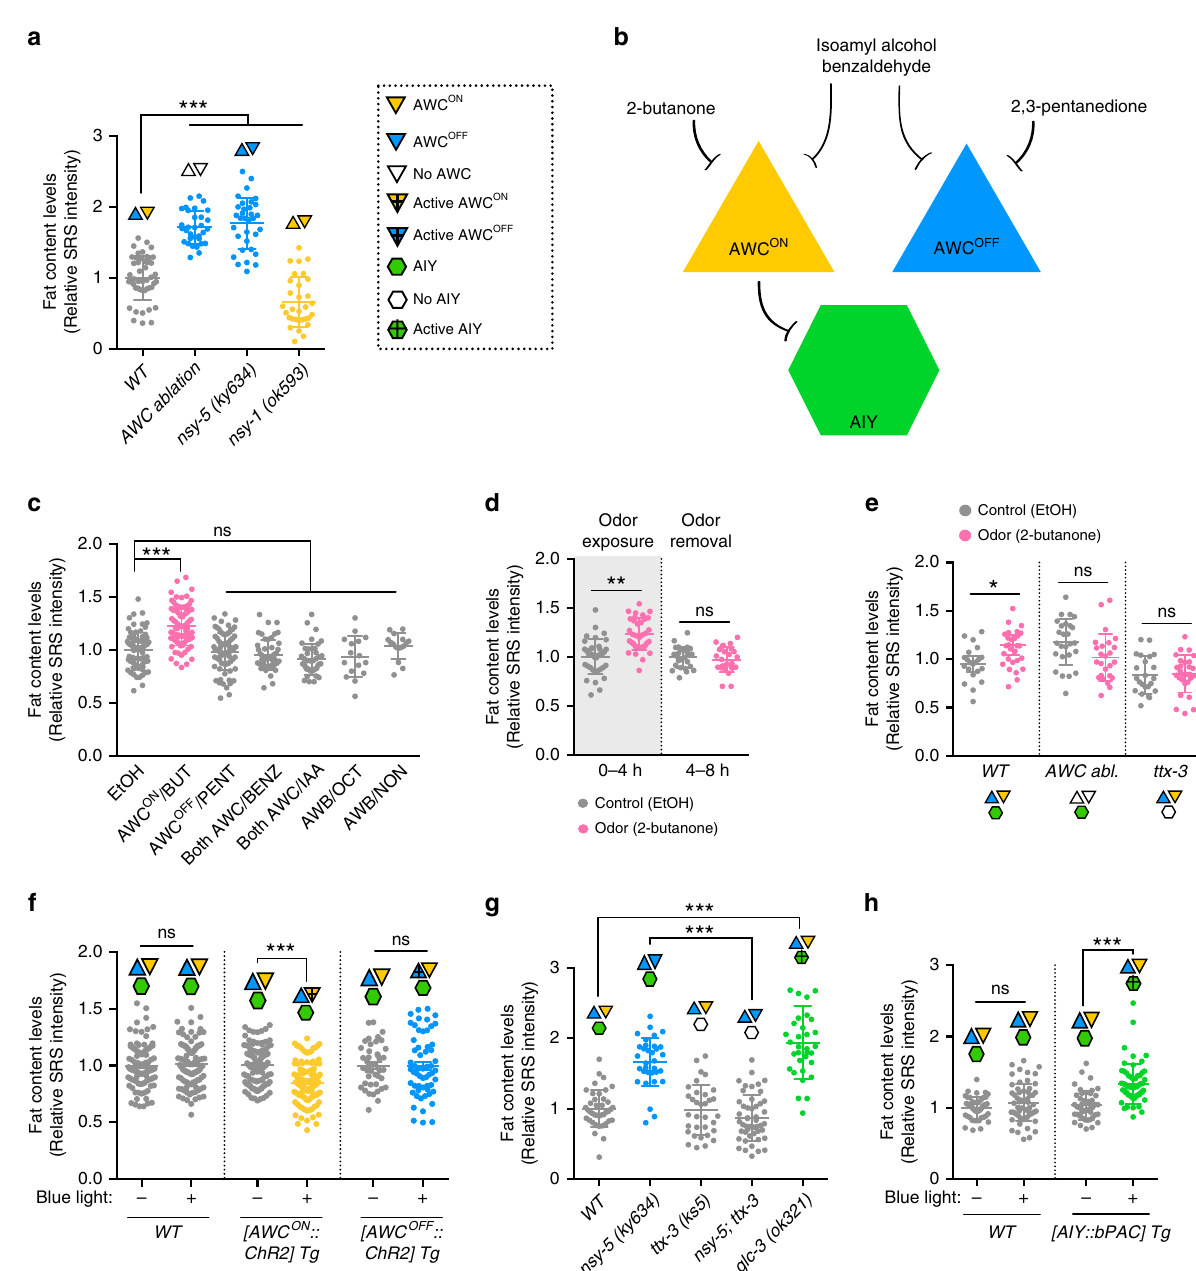
Fig. 3 Speci fi c odors and responding olfactory neural circuit regulate fat metabolism. a Genetic ablation of AWC neurons increases fat storage, while the loss of the asymmetric AWC OFF ( nsy-1 = AWC ON/ON ) or AWC ON ( nsy-5 = AWC OFF/OFF ) neuron leads to reciprocal changes, decreasing or increasing fat levels, respectively. Representative SRS images are in Supplementary Fig. 6c. b Scheme of the odorants and their responding neural circuit with asymmetric AWC olfactory neurons and AIY interneurons. c Exposing WT to 2-butanone that inhibits AWC ON neurons is suf fi cient to increase fat levels. Other odors that target AWC OFF , both AWC, or AWB neurons, do not change fat storage. Worms are exposed to odorants in the absence of food for 4 h. BUT 2-butanone, PENT 2,3-pentanedione, BENZ benzaldehyde, IAA isoamyl alcohol, OCT 1-octanol, NON 2-nonanone. Representative SRS images are in Supplementary Fig. 6d. d Exposure of WT to 2-butanone increases fat storage within 4 h. Upon odor removal, the fat levels are restored back to normal within 4 h. e Lack of AWC (AWC abl.) or AIY ( ttx-3 mutation) suppresses the increased fat storage conferred by 2-butanone. EtOH, negative control. Representative SRS images are in Supplementary Fig. 6e. f ChR2-mediated optogenetic activation of AWC ON is suf fi cient to decrease fat storage levels, but optogenetic stimulation of AWC OFF does not affect fat levels. 1 h blue light stimulation and 1 h in dark in the absence of food followed by SRS imaging. Representative SRS images are in Supplementary Fig. 6f. g Lack of AIY suppresses the increased fat storage in the nsy-5 mutants. Hyperactivity of AIY ( glc-3 mutation) recapitulates the fat storage increase in the nsy-5 mutants. Representative SRS images are in Supplementary Fig. 6g. h bPAC-mediated optogenetic activation of AIY is suf fi cient to increase fat storage. Representative SRS images are in Supplementary Fig. 6h. For a and c data are mean ± s.d., * P < 0.05, ** P < 0.01, *** P < 0.001, n.s. not signi fi cant by one-way ANOVA with Dunnett ’ s test and for d – h by two-way ANOVA with Sidak ’ s test. Numbers of animals used are listed in Supplementary Data 1. For a and c – h , source data are provided as a Source Data fi